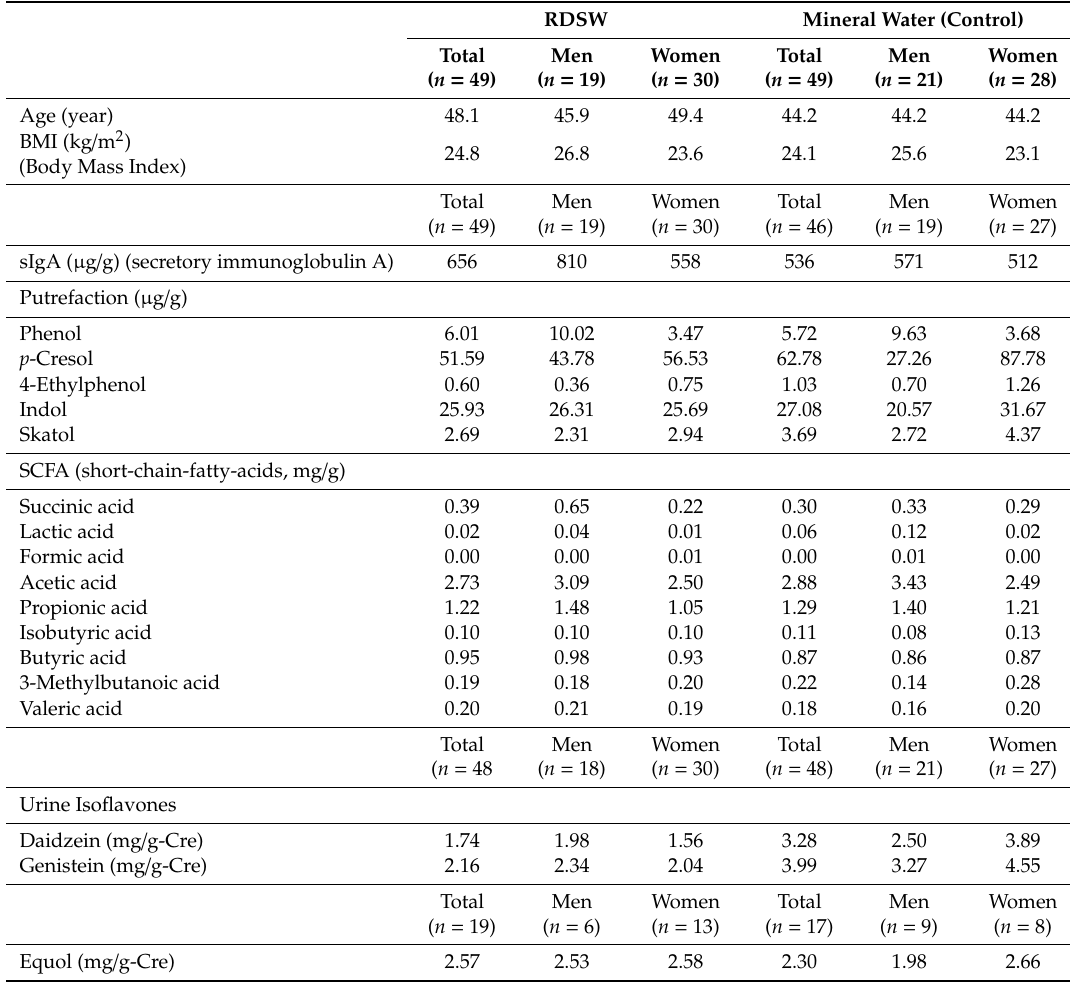
Table 1. Characteristics of participants in pre-intervention of two groups